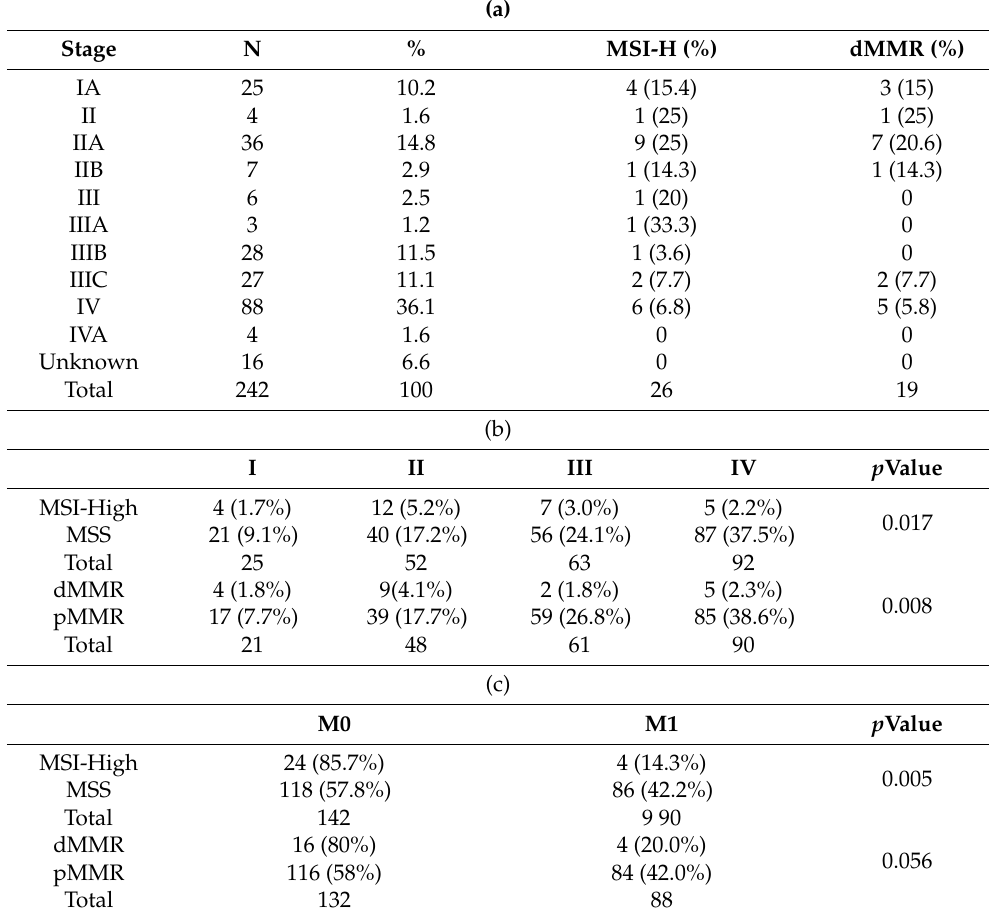
Table 3. ( a ) Description of patients number according to their disease stage. ( b ) Correlation of tumor stage with MSI and MMR status. ( c ) Correlation of MSI or MMR status with metastatic or non-metastatic